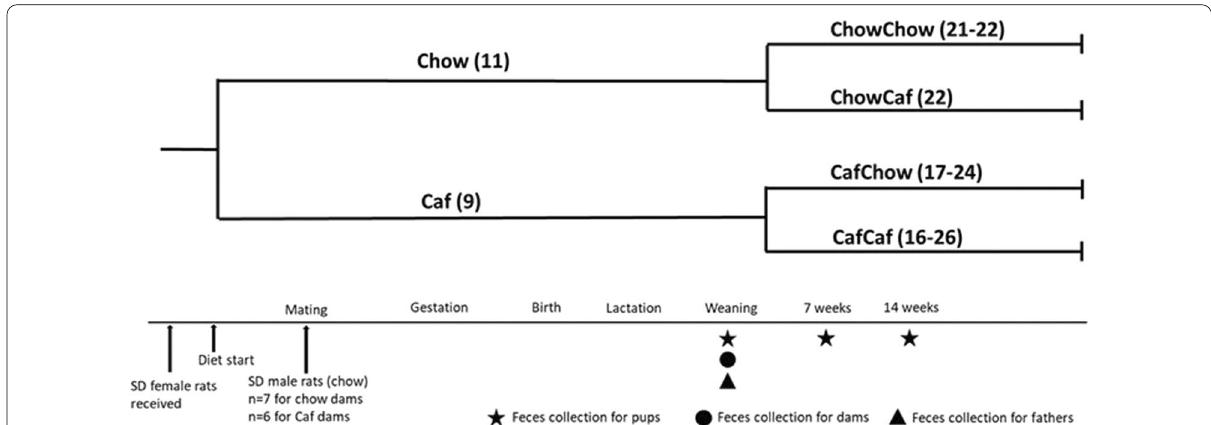
Fig. 1 Experimental design. Female rats were fed chow or Caf diet for 6 weeks, then mated with chow fed males. Fecal samples were collected from mothers and pups at weaning (3 weeks of age). Pups were weaned onto chow or Caf diet, and feces were sampled from a subset of offspring at 7 weeks, and from all remaining pups at 14 weeks of age. Experimental groups consisted of Chow Father; Chow Mother; Caf Mother; Chow Weaner; Caf Weaner; ChowChow; ChowCaf; CafChow; CafCaf at both 7 weeks and 14 weeks; ChowCaf 14 weeks; CafChow 14 weeks; and CafCaf 14